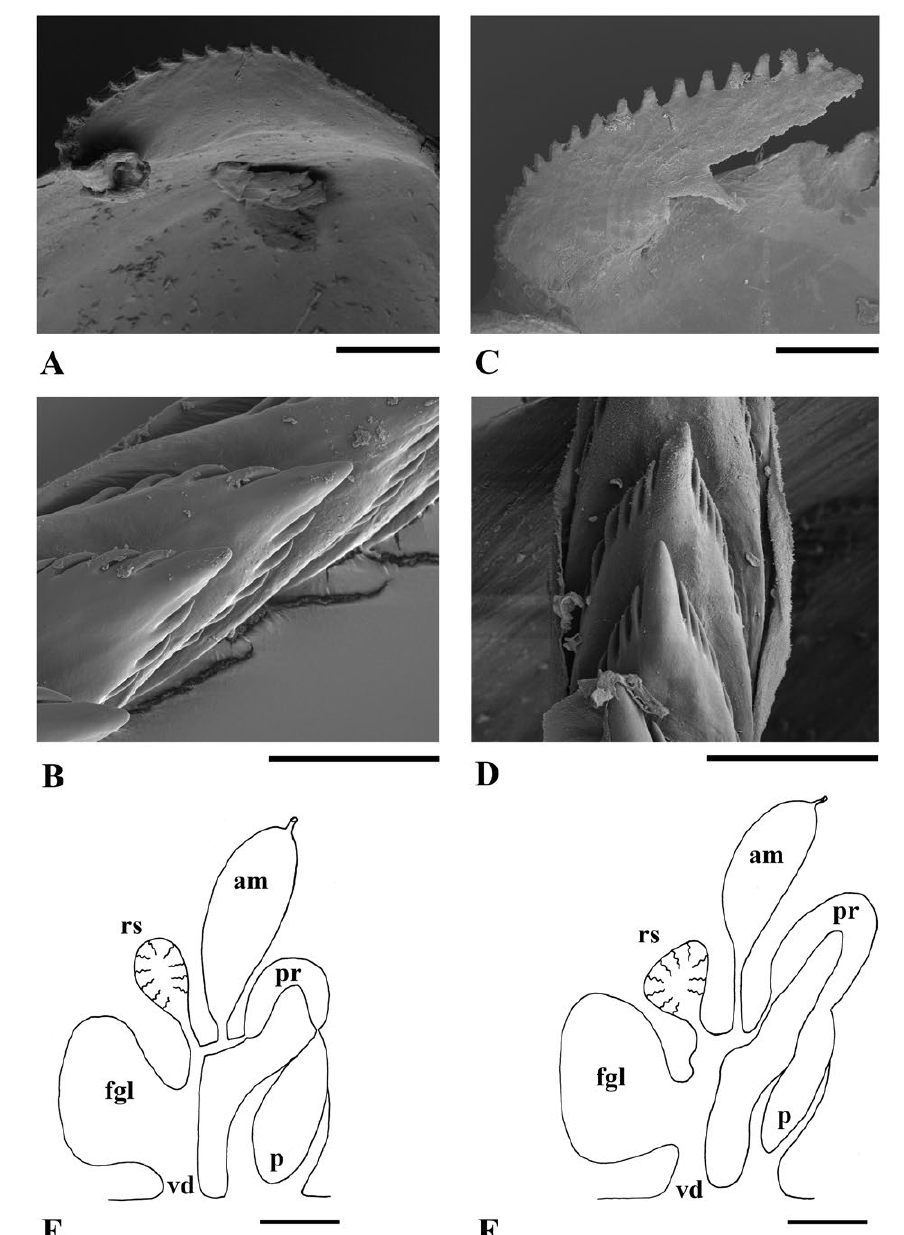
Fig. 3. – Buccal apparatus of C. elegans (A-B) and F. quatrefagesi (C-D). A, C, detail of the jaw denticles. B, D, detail of the rachidian tooth of the radula. Bar scale 50 µm. E, F, schematic drawing of the reproductive systems of C. elegans (E) and F. quatrefagesi (F) respectively. Abbreviations: am, ampulla; fgl, female gland; p, penis; pr, prostate; rs, seminal receptacle; vd, vaginal duct. Scale bar 200